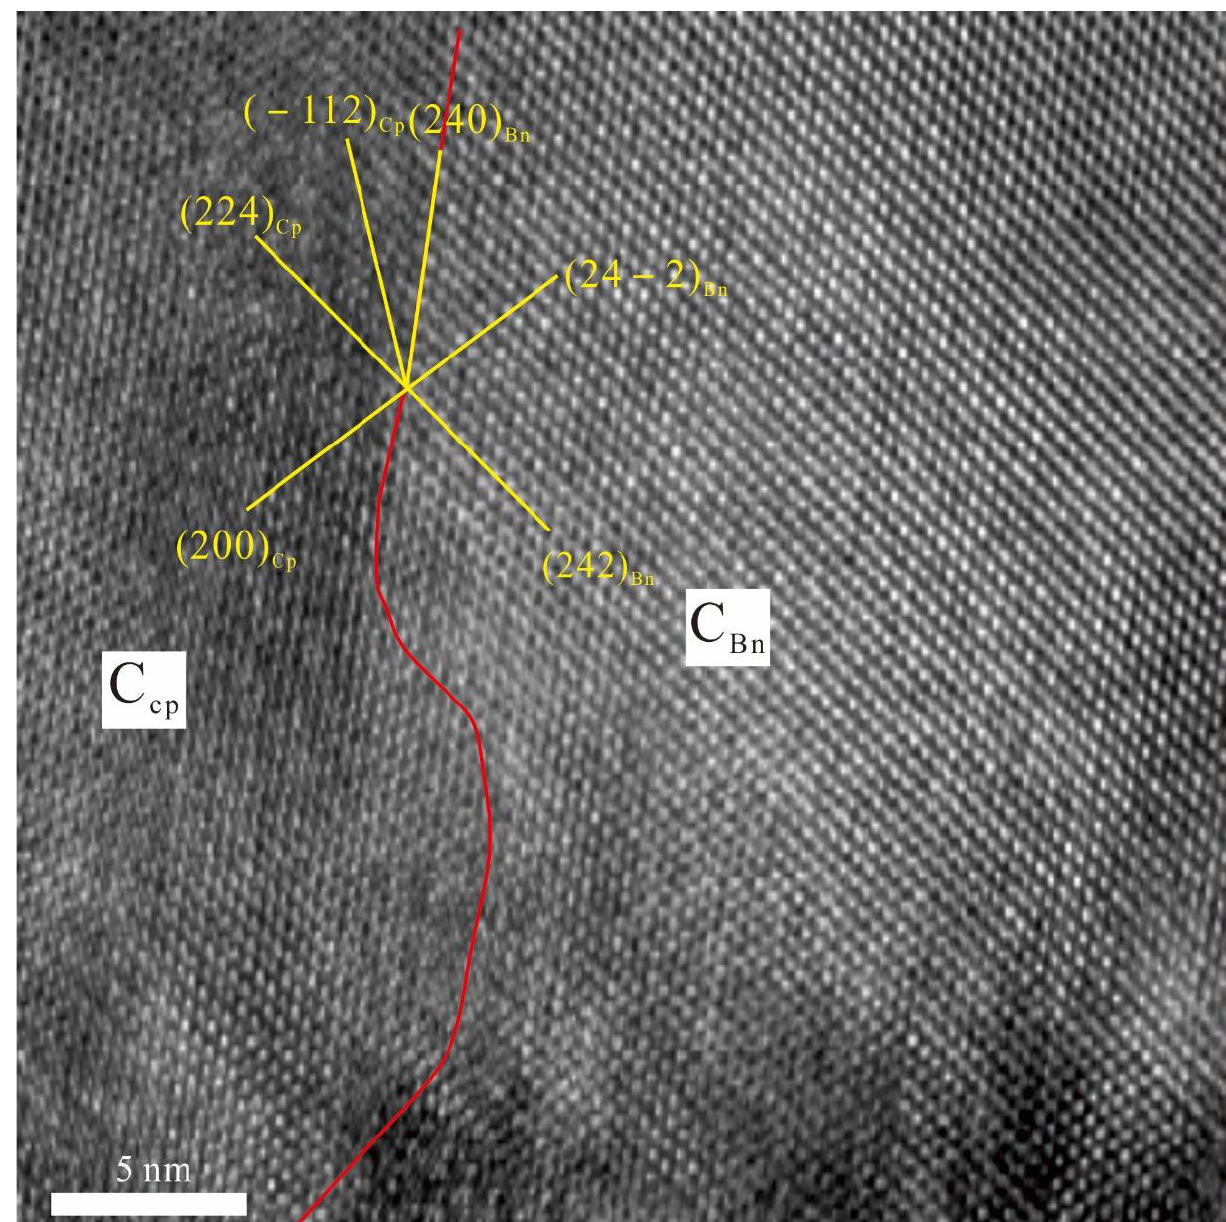
Figure 4. Enlarged HR-TEM imaging of the bornite – chalcopyrite intergrowths, showing that the (200)* and (224)* of chalcopyrite paralleled the (24 − 2)* and (242)* of bornite, respectively. The red line is the boundary of chalcopyrite and bornite.